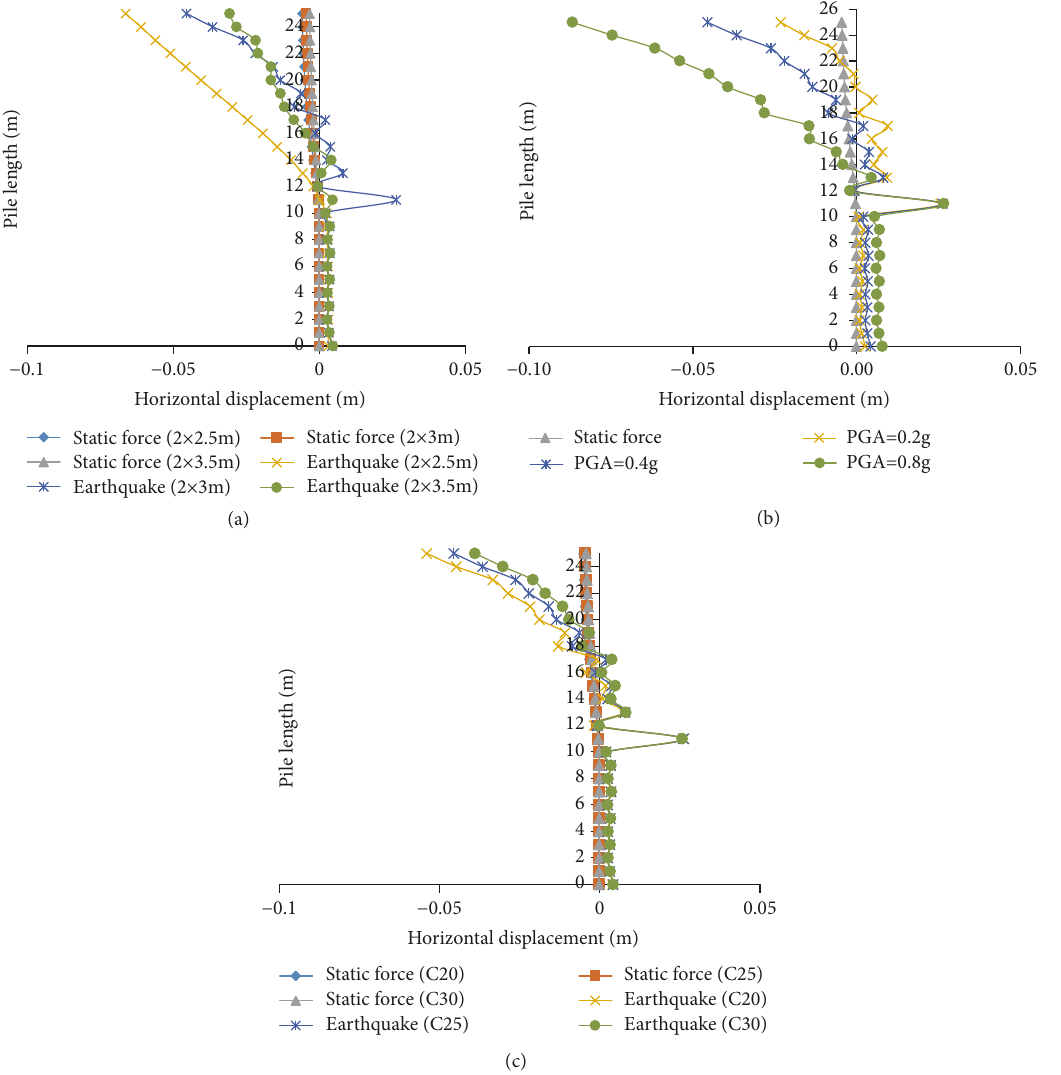
Figure 17: The displacement response curves of stabilizing pile in different working conditions. (a) Different section sizes; (b) different PGAs; (c) different material